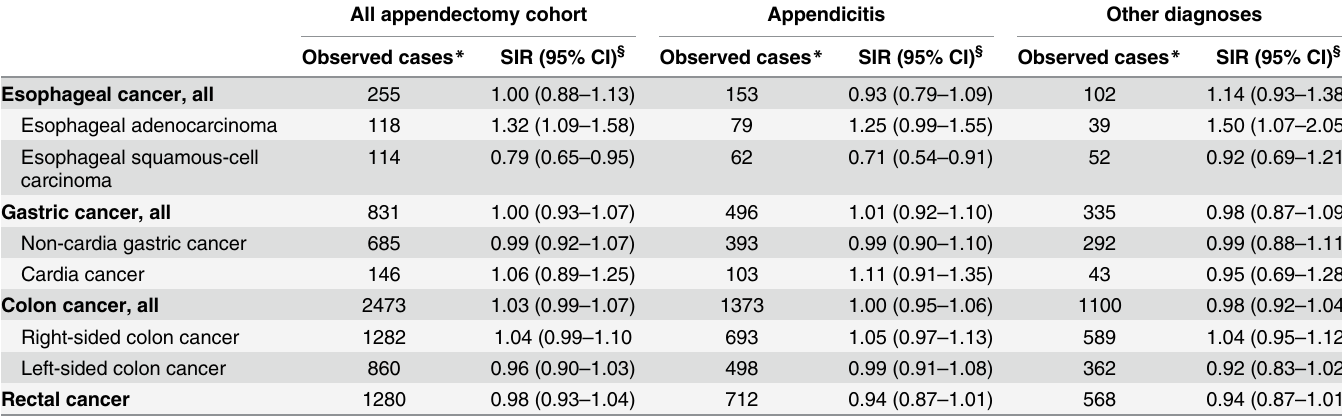
Table 2. Standardized incidence ratios (SIRs) and 95% confidence intervals (CIs) for gastrointestinal cancers in appendectomy patients with dif- ferent discharge